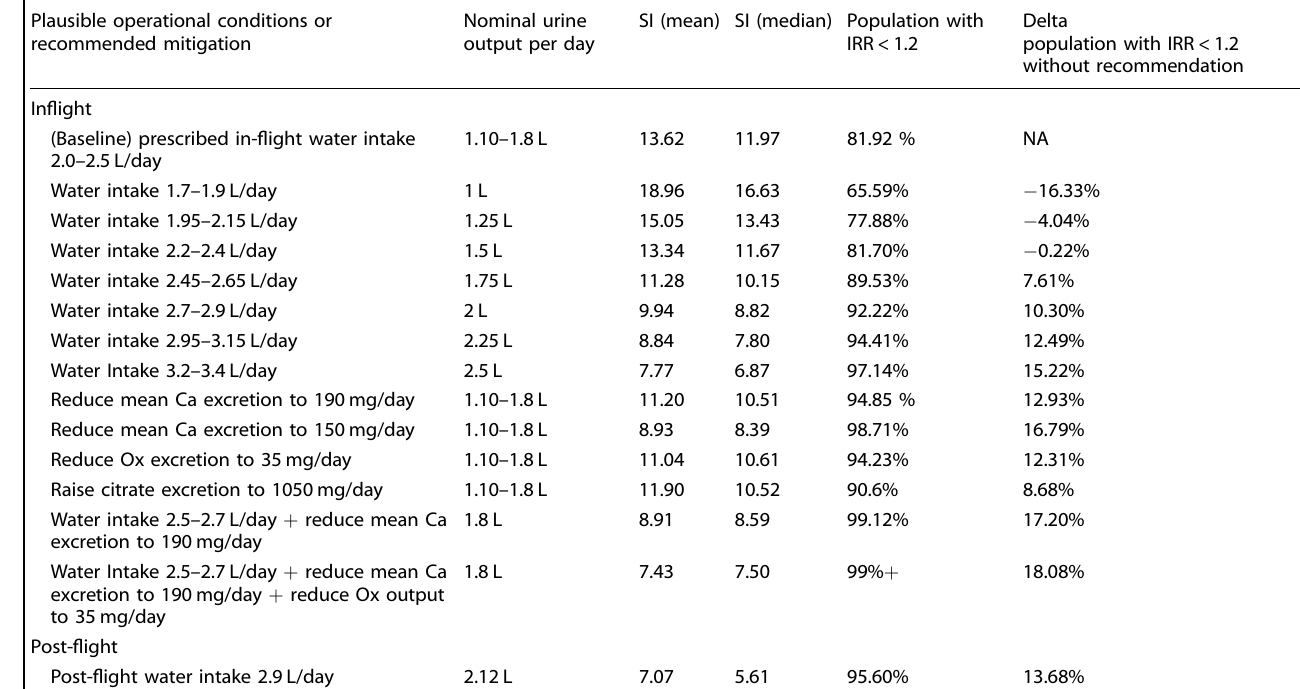
Table 2. The mean and median SI, percentage of the simulated population with IRR < 1.2, and the change in that percentage from baseline for select plausible operational prescriptions and recommended mitigation approaches. Plausible operational conditions or Nominal urine recommended mitigation output per